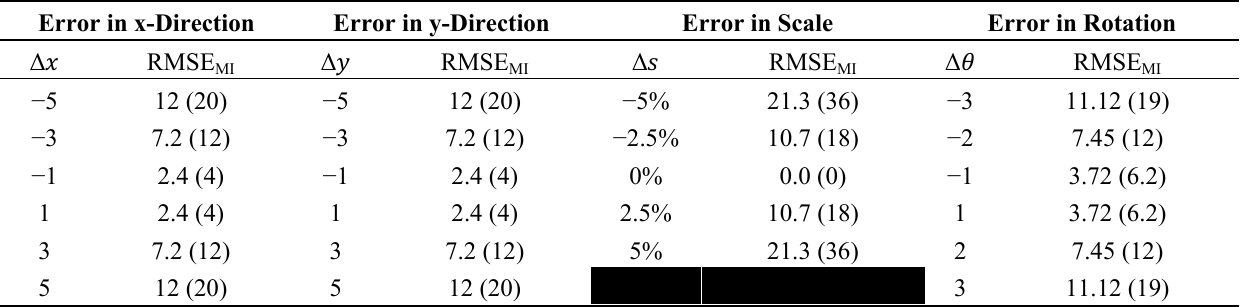
Table 10. The initial RMSE in meters (pixels in LCM) for various cases in Example 2. MI Error in x-Direction Error in y-Direction Error in Scale Error in